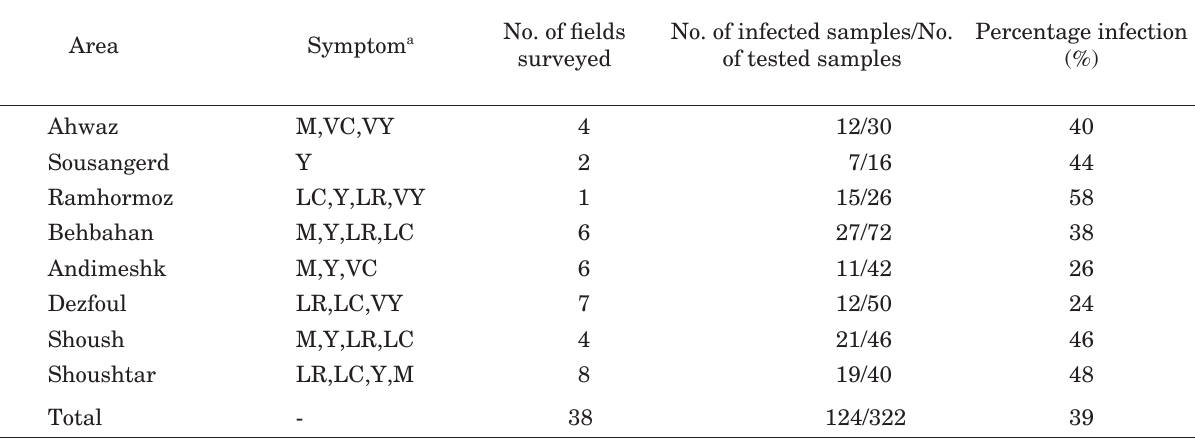
Table 1. Geographical distribution of TYLCV in the eight major tomato growing areas of Khuzestan province, Iran from a fi eld survey in 2006–7.